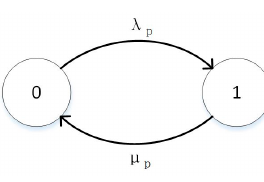
Figure 4. State transition diagram of the primary user (PU).